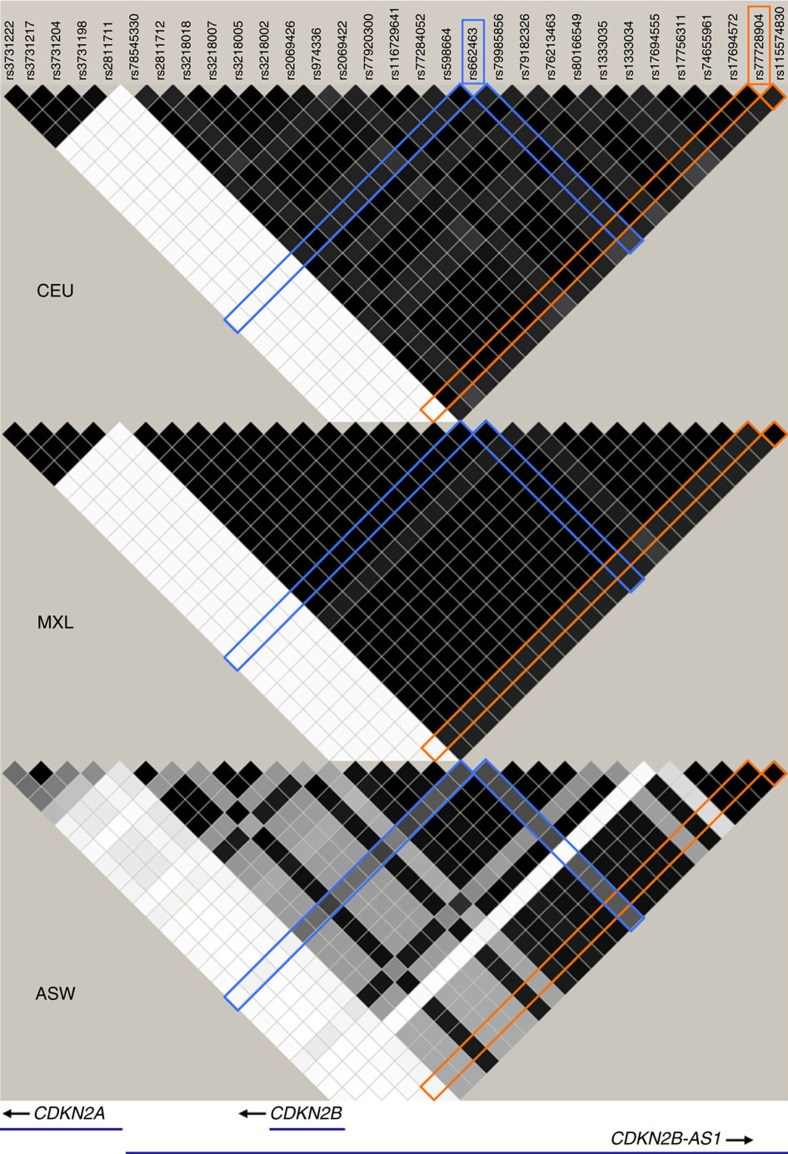
Haploview LD map of the 9p21.3 locus showing differences in the LD structure by ancestry in 1,000 Genomes Phase 1 populations.LD is reported as r2 with r2=0.01 white; 0.01<r2<1 shades of grey; r2=1 black. ASW, African American ancestry; CEU, European ancestry; MXL, Hispanic ancestry. rs77728904 is highlighted in orange and rs662463 is highlighted in blue.